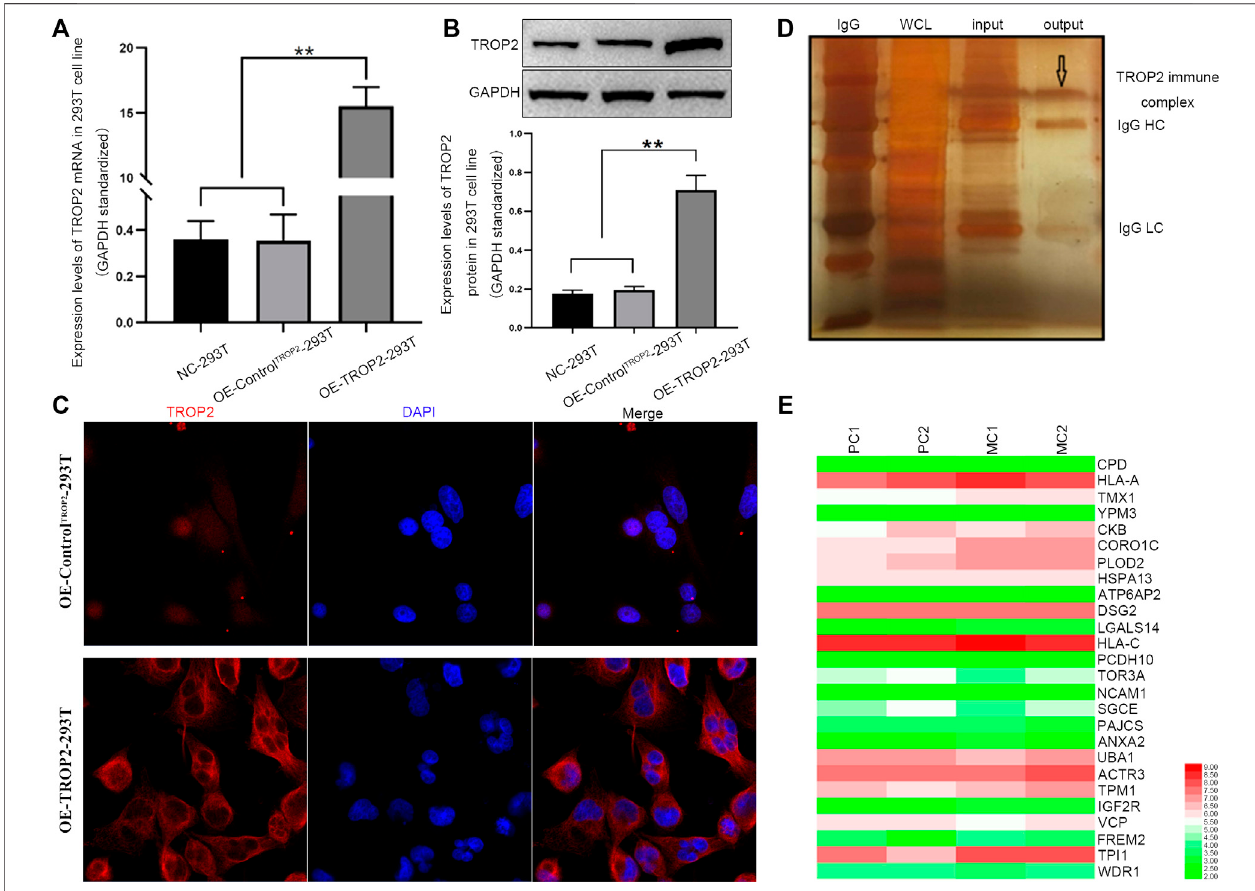
FIGURE 1 | Associations between CORO1C, TROP2, and CRC metastasis. Overexpression of Trop2 in 293T cells was con fi rmed by (A) qRT-PCR, (B) Western blotting, and (C) Immuno fl uorescence. (D) Trop2 immunocomplex by Co-IP; (E) Heatmap of proteins interacting with Trop2 in PC and MC. The RNA-seq data were obtained from GSE28702. Red and green colors represent high and low gene expression, respectively. PC: primary CRC; MC: metastatic CRC, ** p < 0.01.